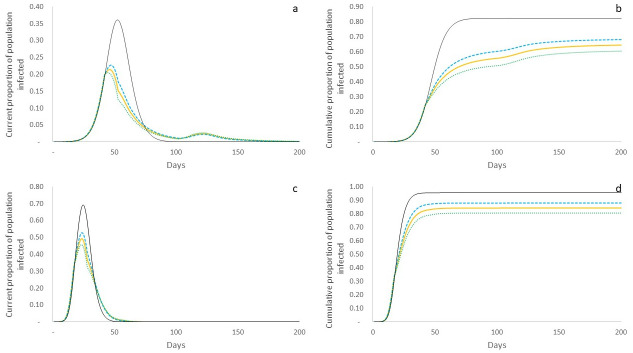
Simulated system outcomes for contact rate reduction scenario.Yellow line represents overall population; dashed blue line represents poor population; dashed green line represents non-poor population; and thin black line represents non-intervention scenario for comparison. a: Current proportion of population infected over time on ER graph. Peak overall caseload is lower than non-intervention scenario with poor population having a higher peak than non-poor, but we see a second peak post intervention, where non-poor are also affected. b: Cumulative proportion of population infected over time on ER graph. Cumulative infected is lower than under non-intervention, but the poor suffer a much higher cumulative infection rate than the non-poor (68% v. 61%). c: Current proportion of population infected over time on BA graph. Poor have higher peak than non-poor, but overall peak is lower than under non-intervention. d: Cumulative proportion of population infected over time on BA graph. Poor have much higher cumulative infection rate than the non-poor (88% v. 81%).